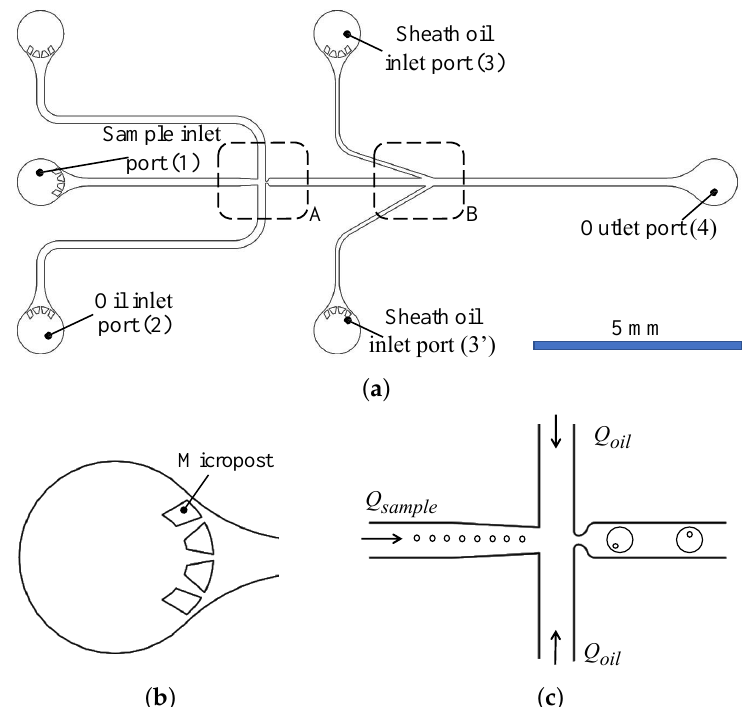
Figure 6. Sheath flow microfluidic chip: ( a ) The chip contains five inlet ports, one for the sample, two for the continuous oil phase, and two for sheath flow. ( b ) Micropost filtration. ( c ) Cross junction emulsification